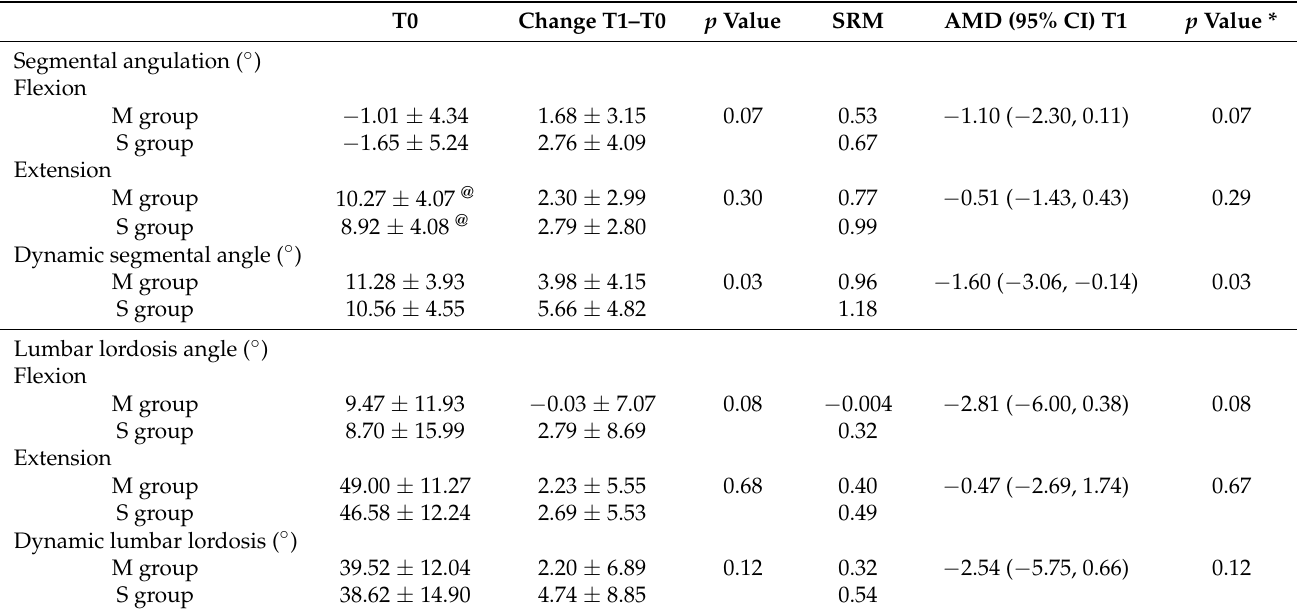
Figure 4. Relationships between VAS score (including all scores of baseline and final VAS) and cor- responding dynamic slip ( A ), and dynamic segmental angle ( B ). The blot picture showed that both dynamic slip and dynamic segmental angle versus pain scores presented an inverse relationship. 4. Discussion The present study examined the effect of alleviating LBP on the variables measured from flexion/extension radiographs of the lumbar spine. We found that 30 mg of IM ad- ministered ketorolac was effective for alleviating LBP and caused an increased motion of spondylolisthesis segments in aspects of 2.4 (± 1.36) mm in DS, 4.85 (± 4.59) degrees in DA, and 6.23 (± 3.46)% in SP. About 32% more patients with segmental instability were de- tected in lateral flexion/extension radiography after pain relief. Severe pain (VAS > 70 mm) could prevent patients from performing adequate flexion/extension exercises, resulting in an underestimation of the segmental instability. The reoperation rate of DLS has been reported to be high both in either decompres- sion alone or decompression plus fusion surgery [21–24]. Although widely investigated, the exact mechanisms of reoperation remain elusive. The instability occurrence on adja- cent segments was the most common pathology in lumbar fusion or dynamic stabilization surgery [21–23]. Patients with low-grade DLS are more likely prone to experience postop- erative instability after decompression laminectomy surgery in the presence of segmental translation > 1.25 mm, disc height > 6.5 mm, and facet angle > 50° [25]. The determination